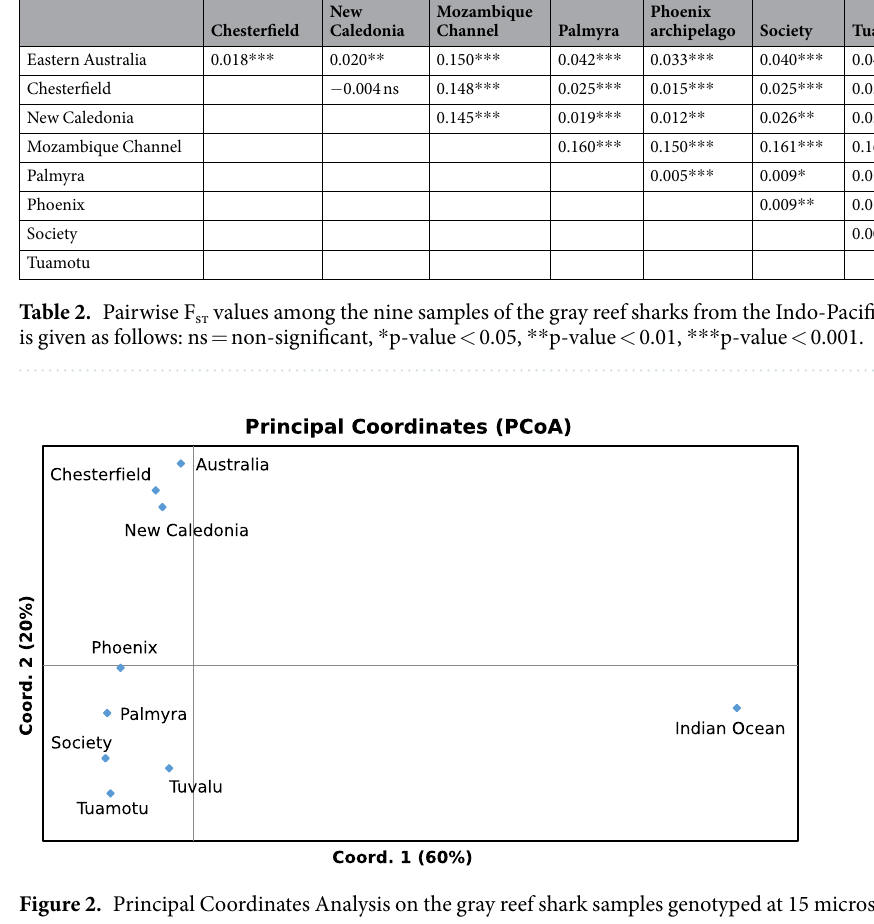
Tuamotu, or for localities with few specimens (Tuvalu N = 4, Table 2). Regarding the PCoA, the second axis clearly separated West Pacific samples (Australia, Chesterfield and New Caledonia) and Central Pacific samples (Tuvalu, Phoenix, Palmyra and French Polynesia, Fig. 2). The Bayesian clustering, focusing on Pacific specimens only, also revealed Central and West Pacific groups but showed further segregation within the Central Pacific samples: Phoenix, Tuvalu and Palmyra grouped together while French Polynesia was separated in another group with a distinct genetic composition (Fig. 3b). At the scale of an archipelago (Phoenix) or two close archipelagos